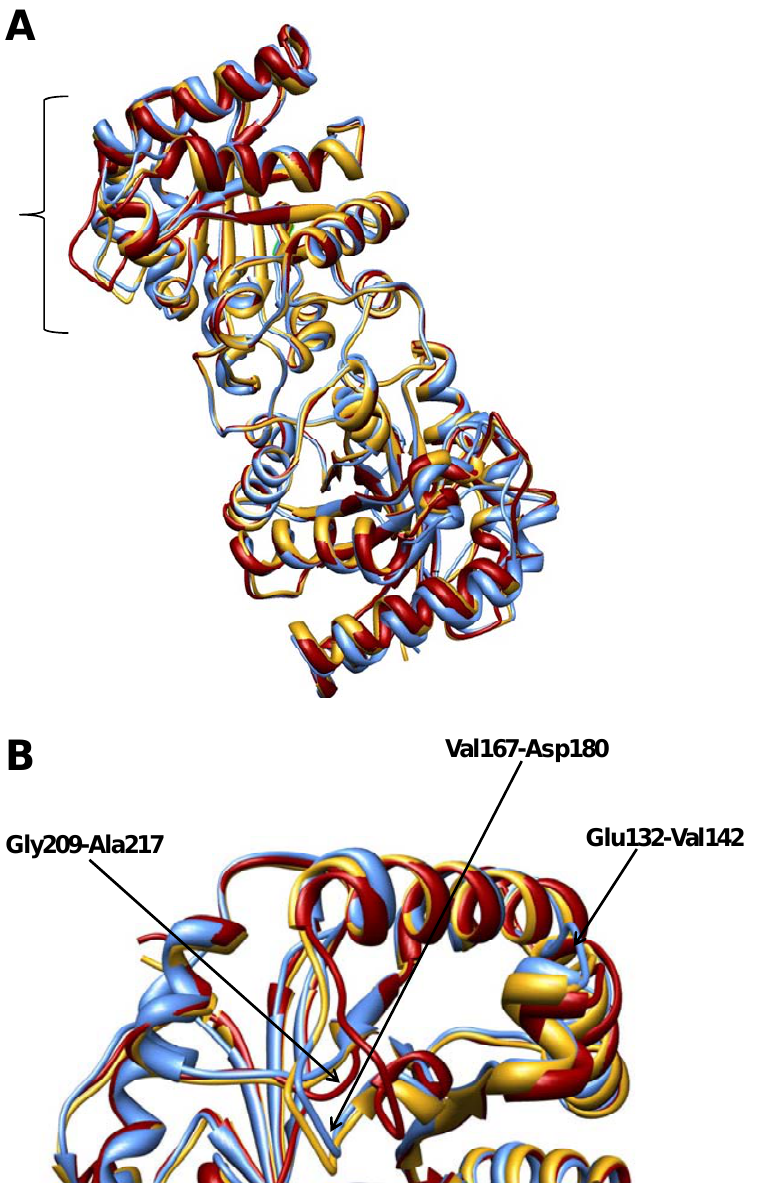
Figure 1. Structural alignment of triosephosphate isomerases from Saccharomyces. cerevisiae . ( A ) Mutant C126S (gold) and the wild-type enzyme in the absence (red, 1YPI) and in the presence of PGA (blue, 2YPI); ( B ) Close-up view of the three regions